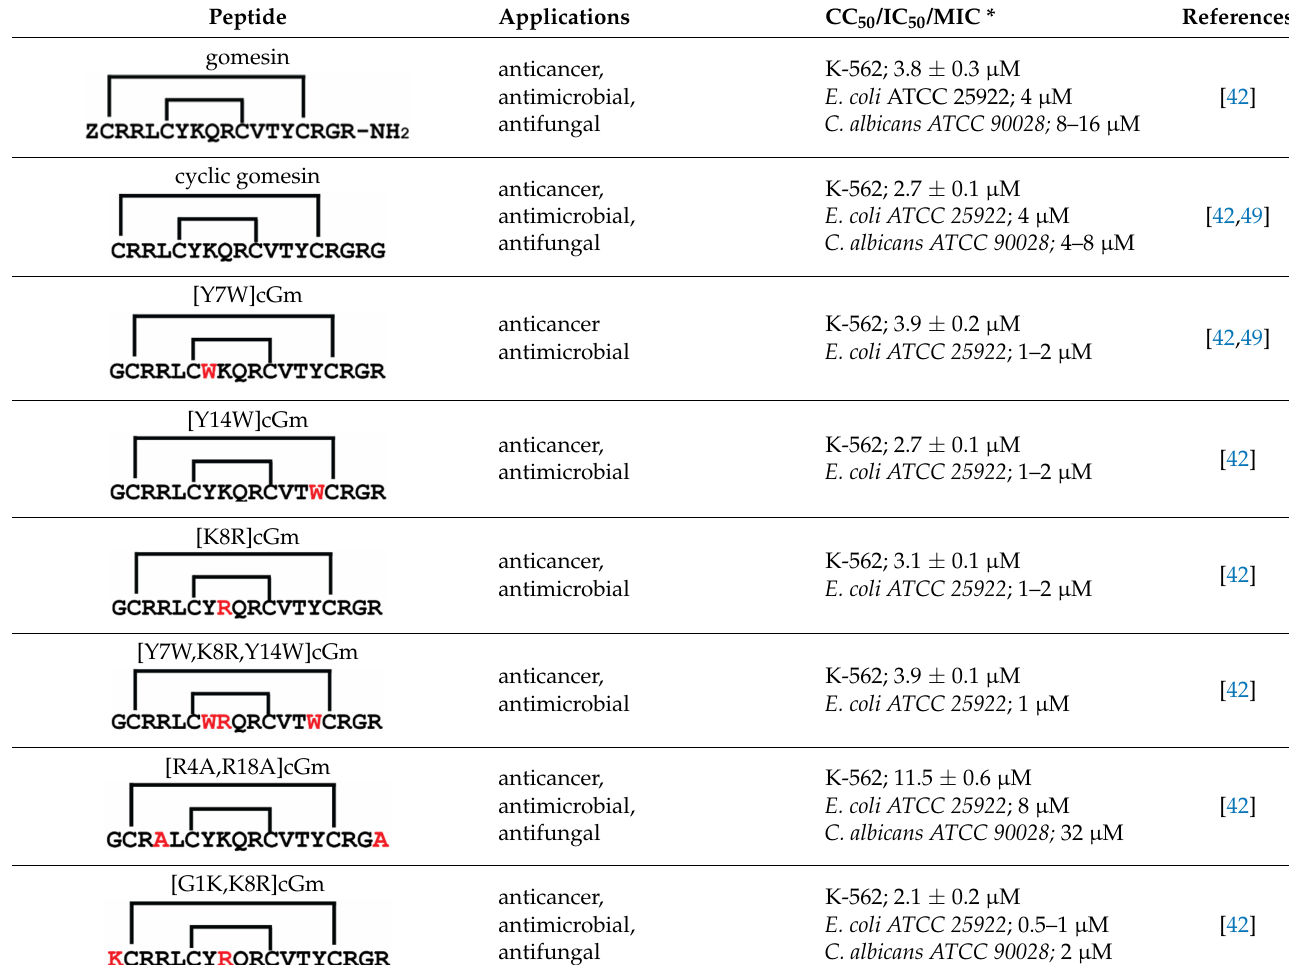
Table 2. Examples of Gm and cGm analogues with anticancer or antimicrobial activities. Peptide